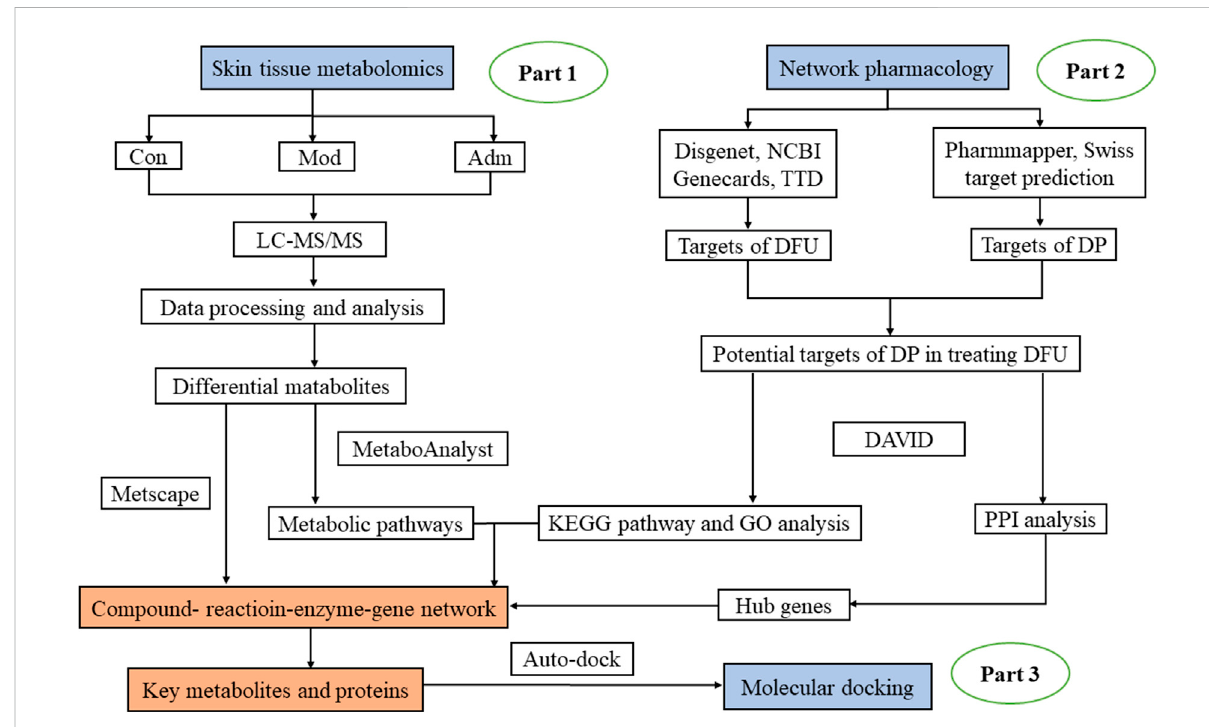
FIGURE 1 The fl owchart of the integrated methods. The mechanisms of DP in treating DFU was explored with metabolomics of skin tissues (Part 1). Network pharmacology was performed to extract hub gene (Part 2). Through Part 1 and 2, important targets and metabolites were identi fi ed and connected. Molecular docking was conducted to further verify these core targets (Part